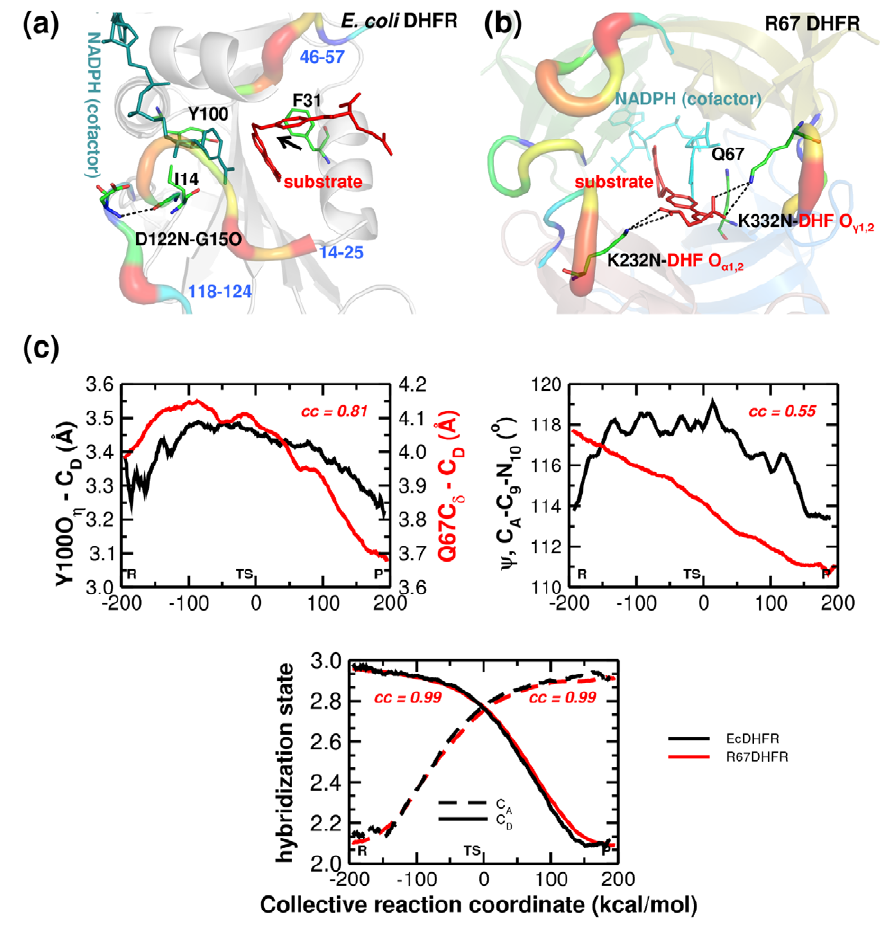
Figure 4. Comparison of reaction-coupled flexibility in non-homologous DHFRs. (a) Hydride transfer between cofactor NADPH and substrate DHF catalyzed by E. coli DHFR and R67 DHFR with dissimilar enzyme folds. In E. coli DHFR residues D122, G15, I14, and Y100 provide promoting motion to the cofactor nicotinamide ring and F31 motions alters the chemical environment on the reactant [12]. In R67 DHFR the Q67 provides the promoting motion to the nicotinamide ring and the movement of substrate tail in open pore, controlled by hydrophilic interactions between residues K32 from two different sub-units (labeled as K232 and K332) and a / c carboxylate groups of the substrate p-ABG tail. Note the four monomers in R67 DHFR are colored differently and the hydrophilic interaction between the cofactor tail and the K232 and K332 are shown. (b) The network residue Y100 in E. coli DHFR and Q67 in R67DHFR are positioned behind the nicotinamide ring and provide similar promoting motions to C D . The puckering of the pteridine ring of the DHF substrate at the C A is also a contributor to the reaction coordinate. The change in DHF-tail angle ( y , C A –C 9 –N 10 ) from sp2 ( , 120 u ) to sp3 ( , 109 u ) state of hybridization is induced by different features of the enzyme folds. The overall effect on the reaction center chemical environment is the same as indicated by the state of hybridization of the C D and C A . Note, cc values indicate correlation coefficients between the quantities from the two folds calculated over the course of reaction profile. See ref. [62] for further details.